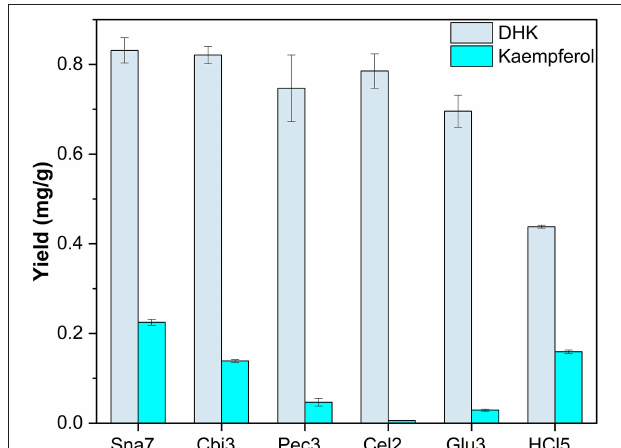
FIGURE 5 | Aglycone yields (mg/g) from flower extracts of P. × hybrida . Enzymatic hydrolysis (25min): Sna7: 5mg snailase (pH 5.5, 37 ◦ C); Cbi3: 5U cellobiase (pH 4.5, 37 ◦ C); Pec3: 20U pectinase (pH 4.5, 40 ◦ C); Glu3: 20U β -glucosidase (pH 5.5, 37 ◦ C); Cel2: 20U cellulase (pH 6.0, 52 ◦ C). Acidic